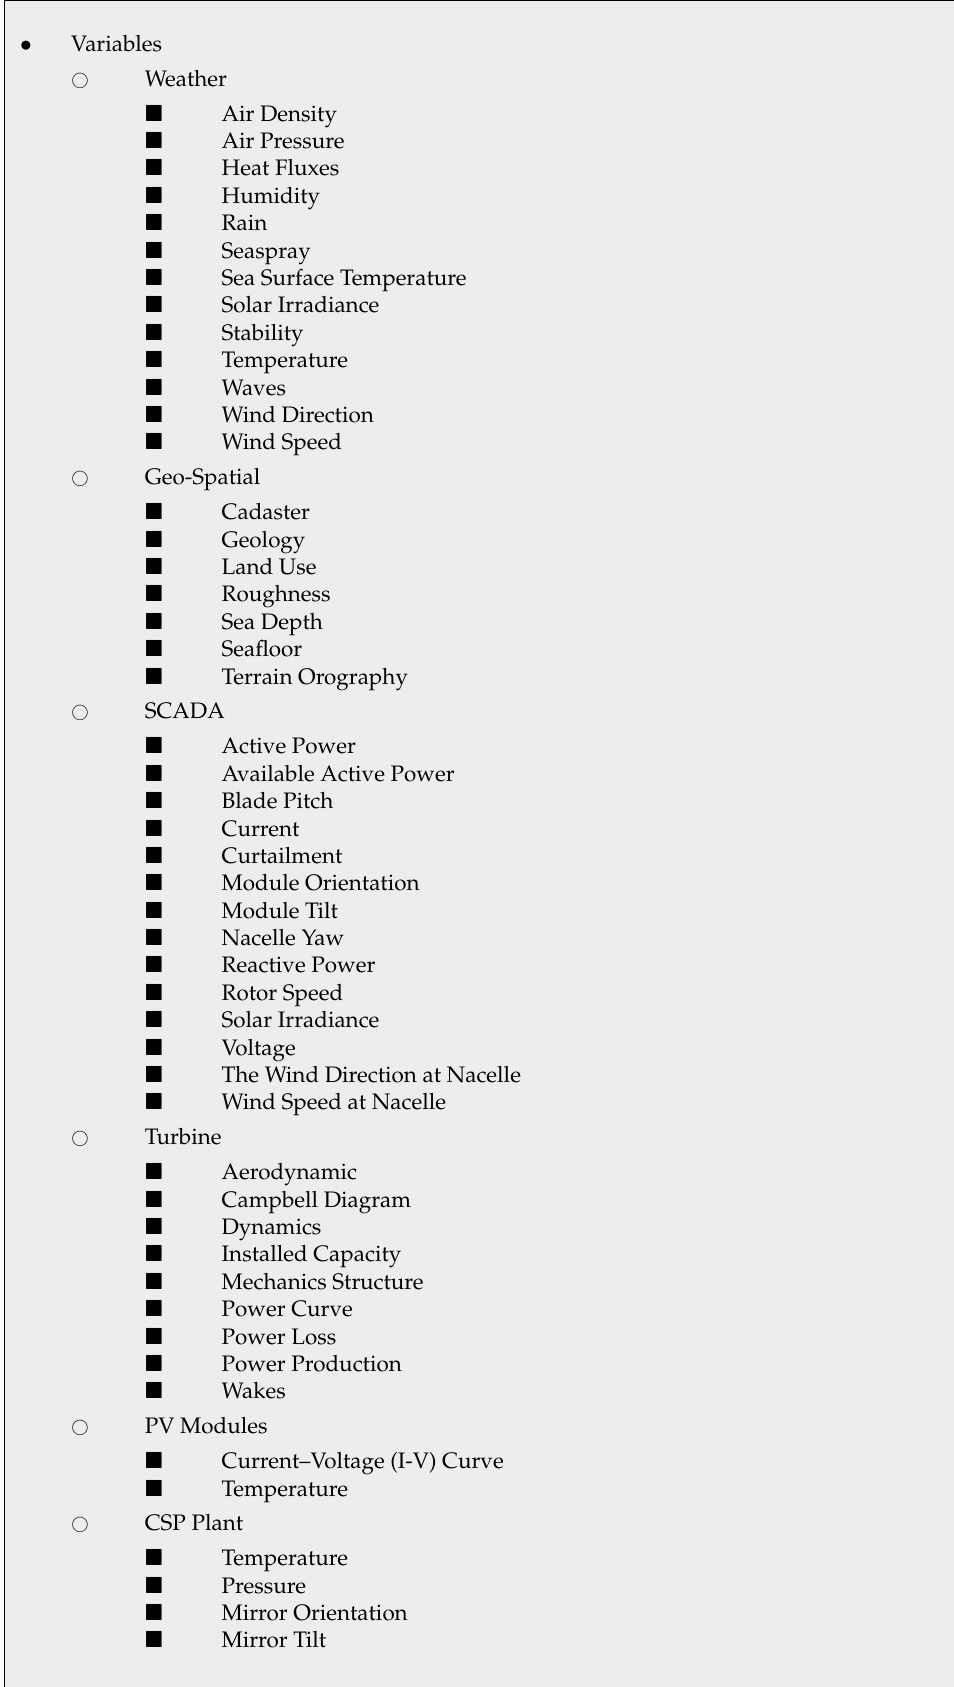
Table 22. Hierarchy for Variable-related